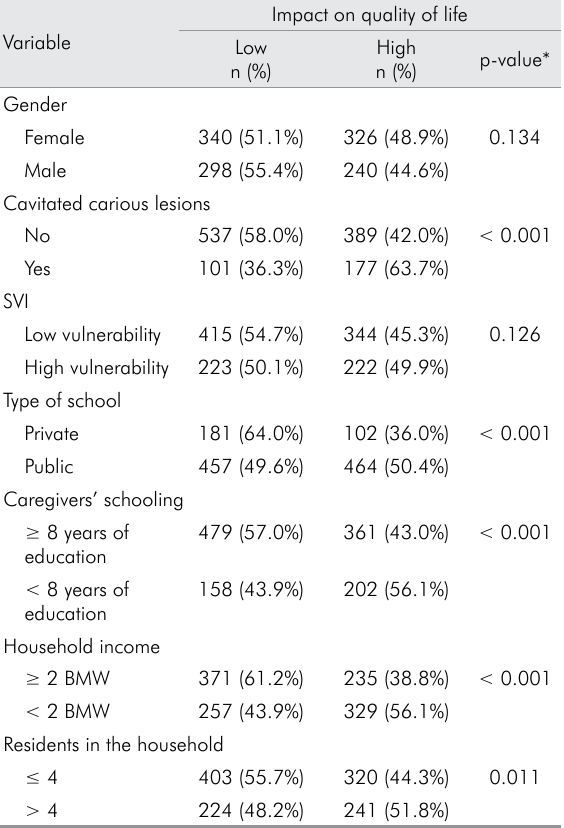
Table 1. Distribution of the sample according to the severity of the impact on quality of life and associated